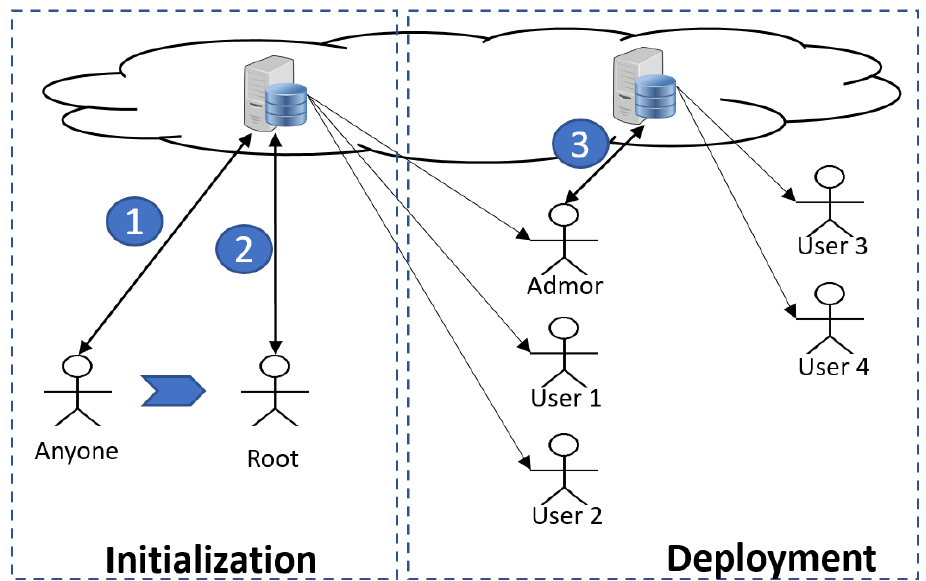
Figure 1. General phases for the generation of users in computer systems based on the cloud; circle numbers denote